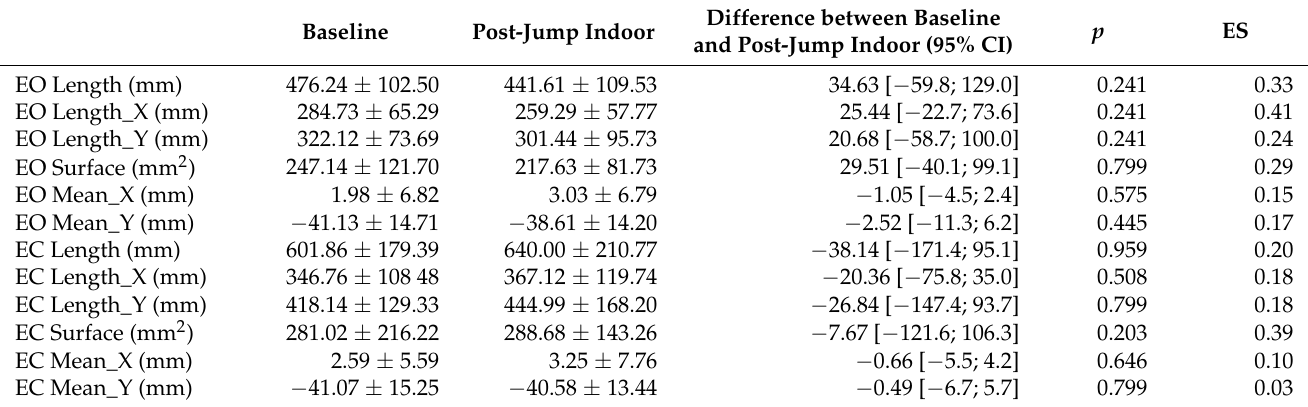
Table 2. Pre- and post-jump indoor descriptive values and the